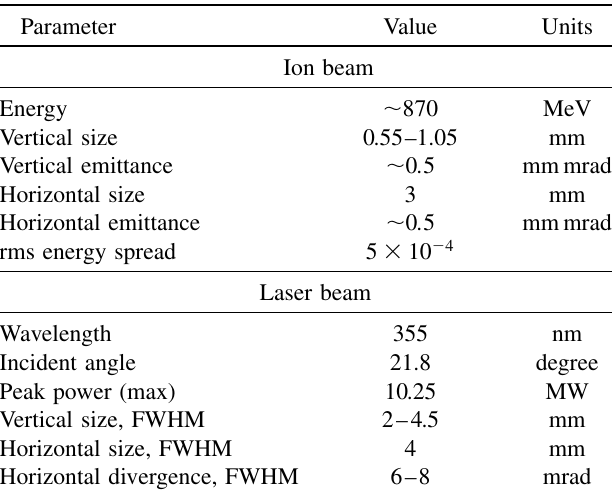
TABLE I. Laser and ion beam